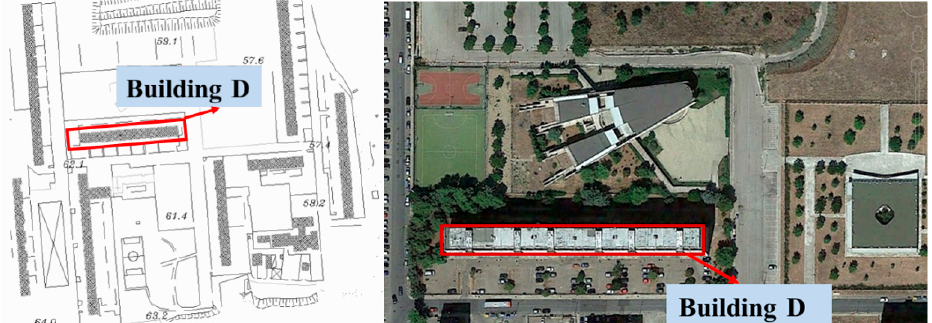
Figure 7. Positioning of Building D in Santa Rita district, in the neighborhood of Bari, Italy.